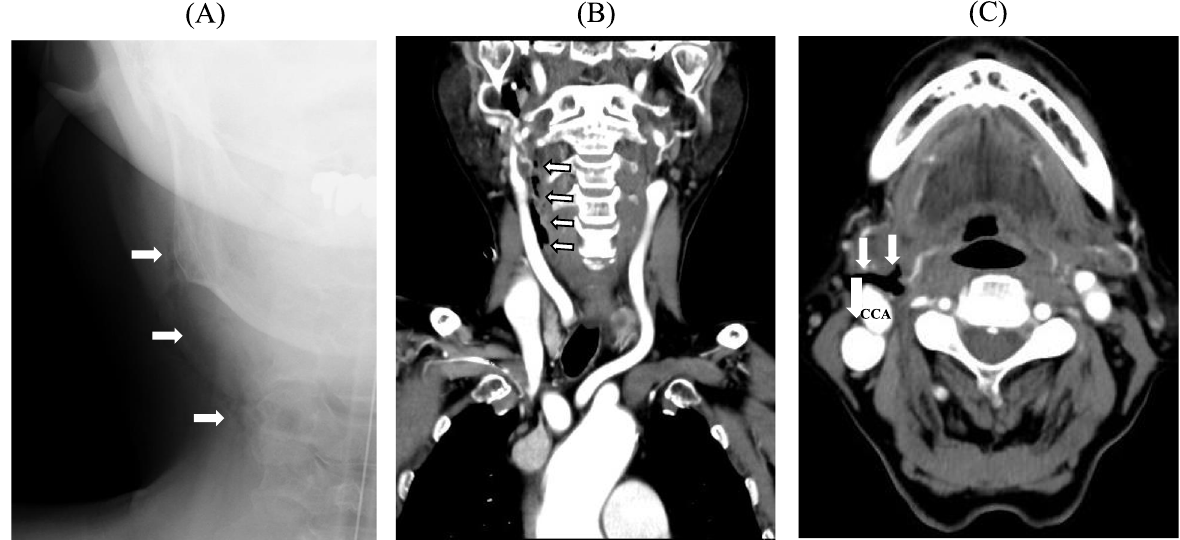
Fig. 1 Postoperative chest X-ray ( A ) and contrast-enhanced computed tomography ( B ) ( C ) images. Subcutaneous emphysema was observed in the right side of the neck ( A ), and it extended up to the right carotid artery ( B ) ( C ). CCA, common carotid